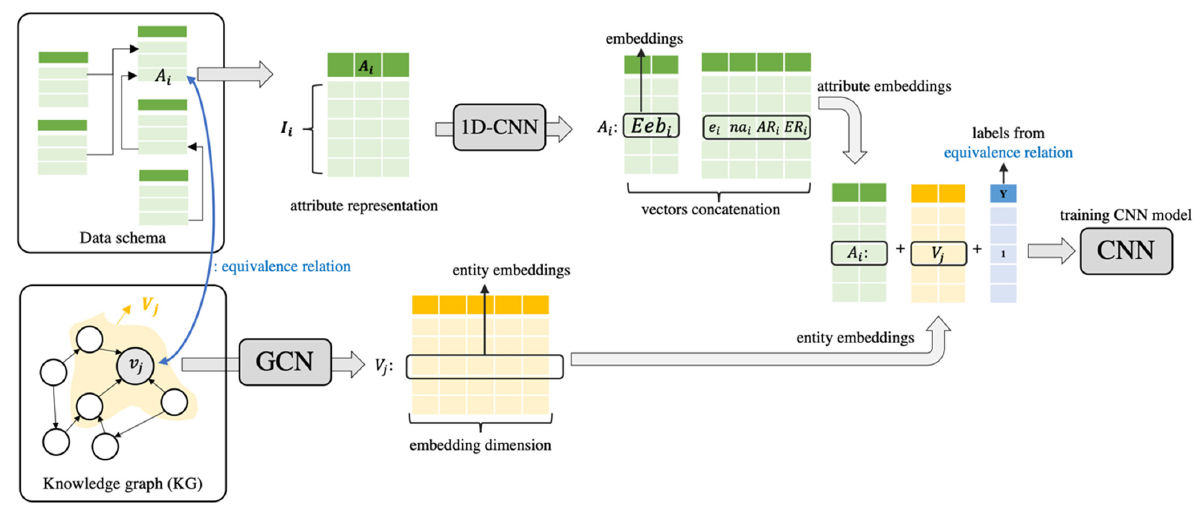
Figure 4. The entity alignment between attributes and vertices with the CNN model.